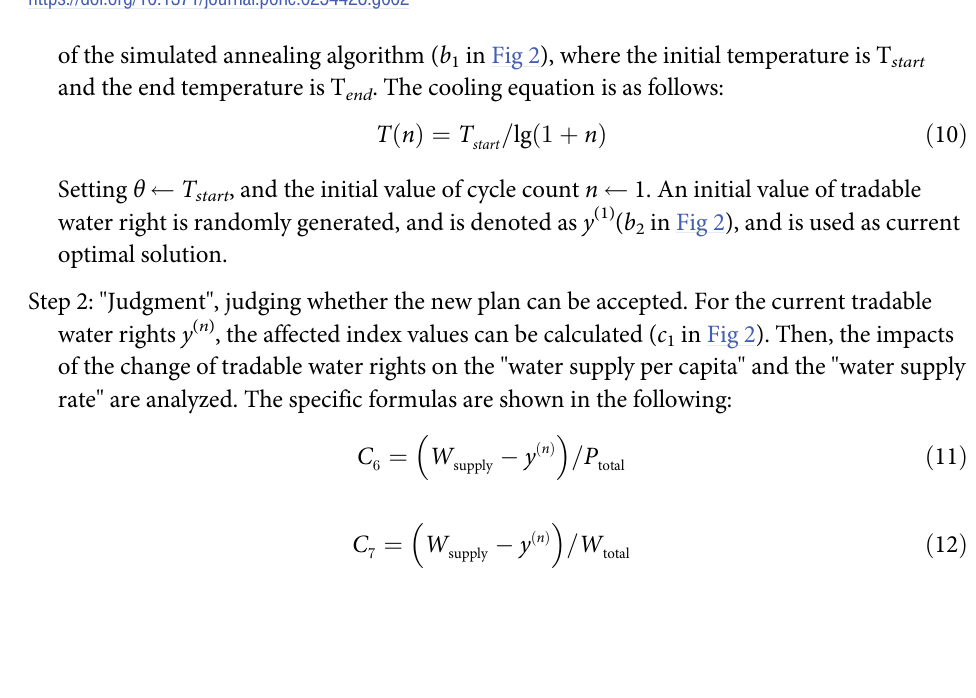
Fig 2. Flow chart of the simulated annealing algorithm for calculating tradable water rights.